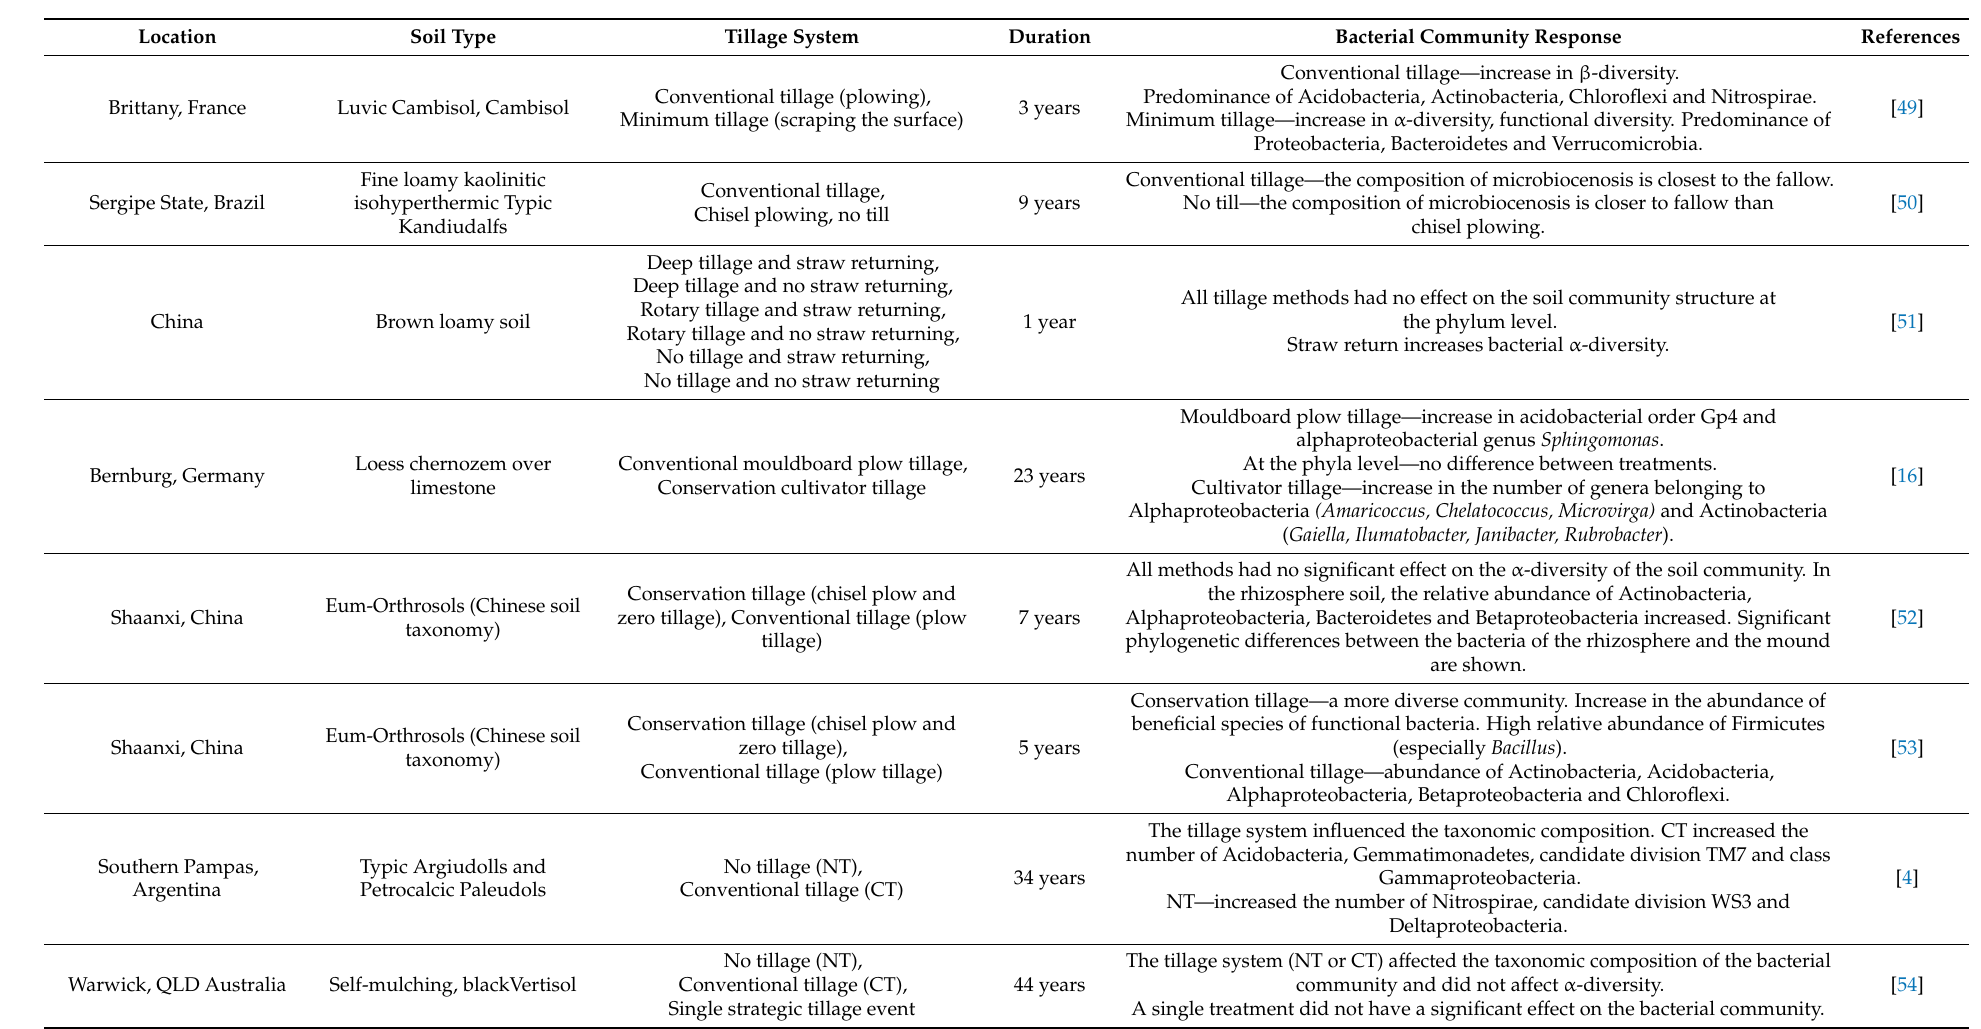
Table 2. Influence of tillage/no tillage on the bacterial community of agricultural